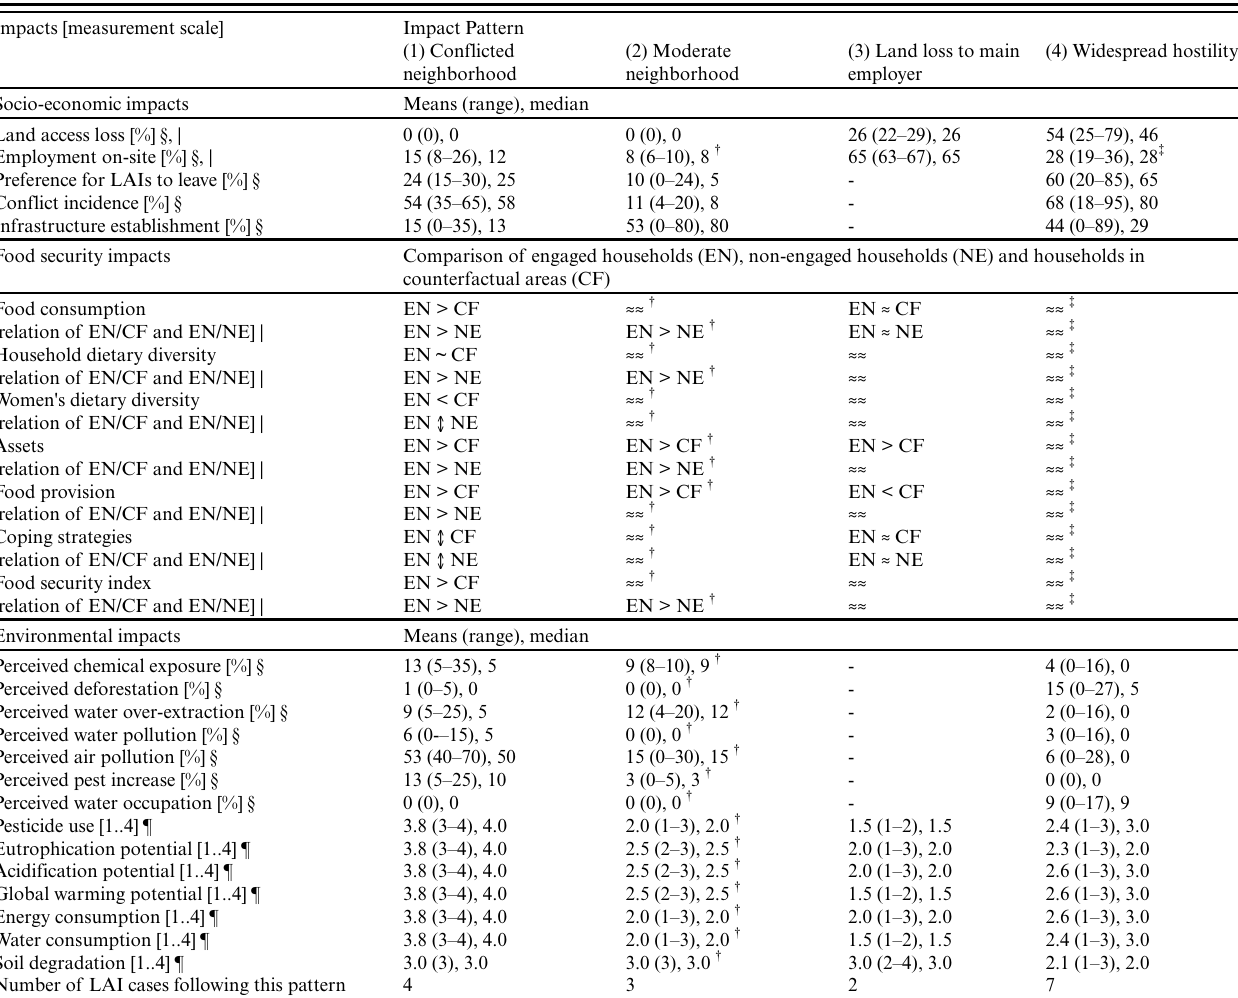
(1) Conflicted neighborhood